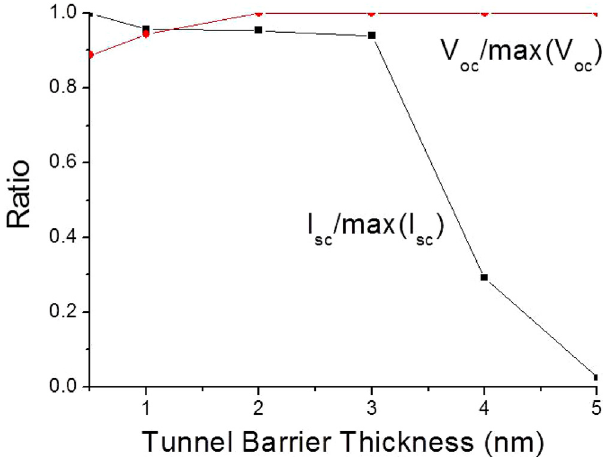
Fig. 6. I sc /max ( I sc ) and V oc /max ( V oc ) versus the thickness of the tunnel barrier t B . Assuming a thick barrier excited states are very thin and energy mesh has to be also very thin. From a computational point of view we cannot conduct the calculation for tunnel thicker than 3nm assuming the transverse dispersion. This calculation has then been conducted only for a transverse wave vector equals to